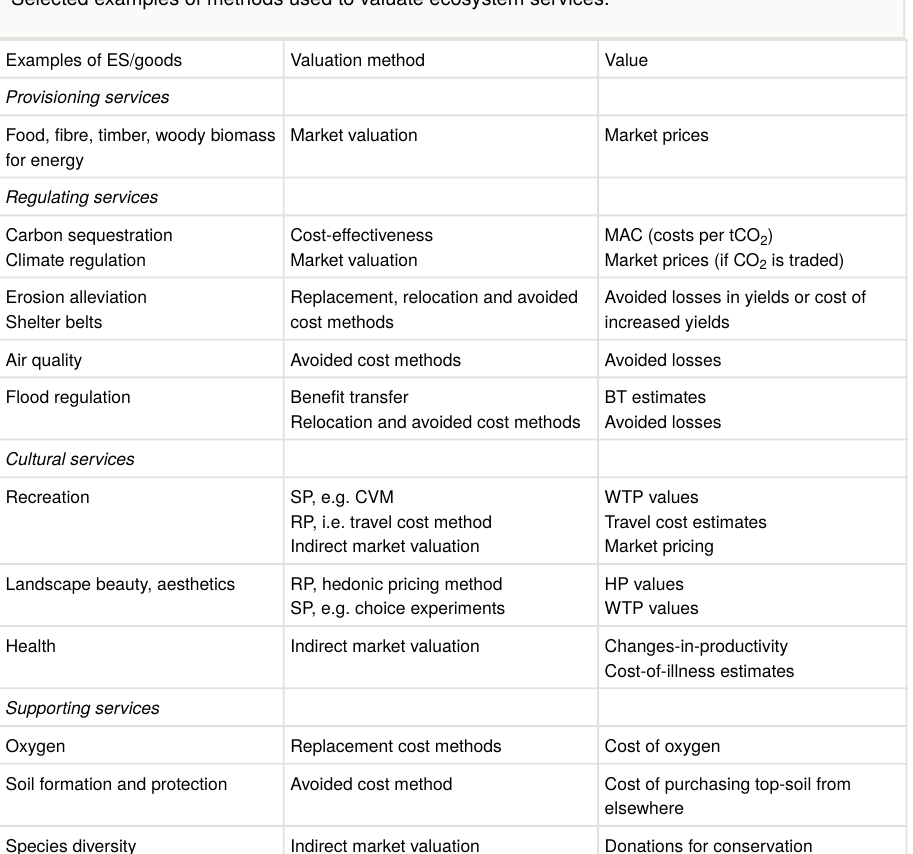
Selected examples of methods used to valuate